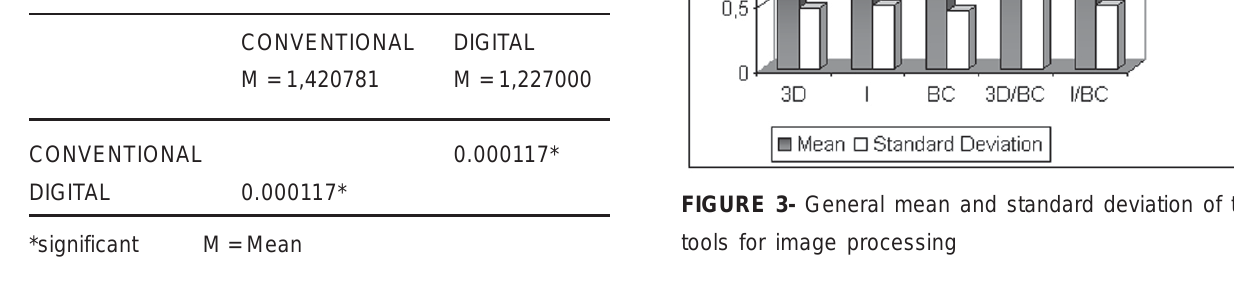
TABLE 4 - TUKEY test (HSD) for establishment of the group (C / D) with significant difference as to the method